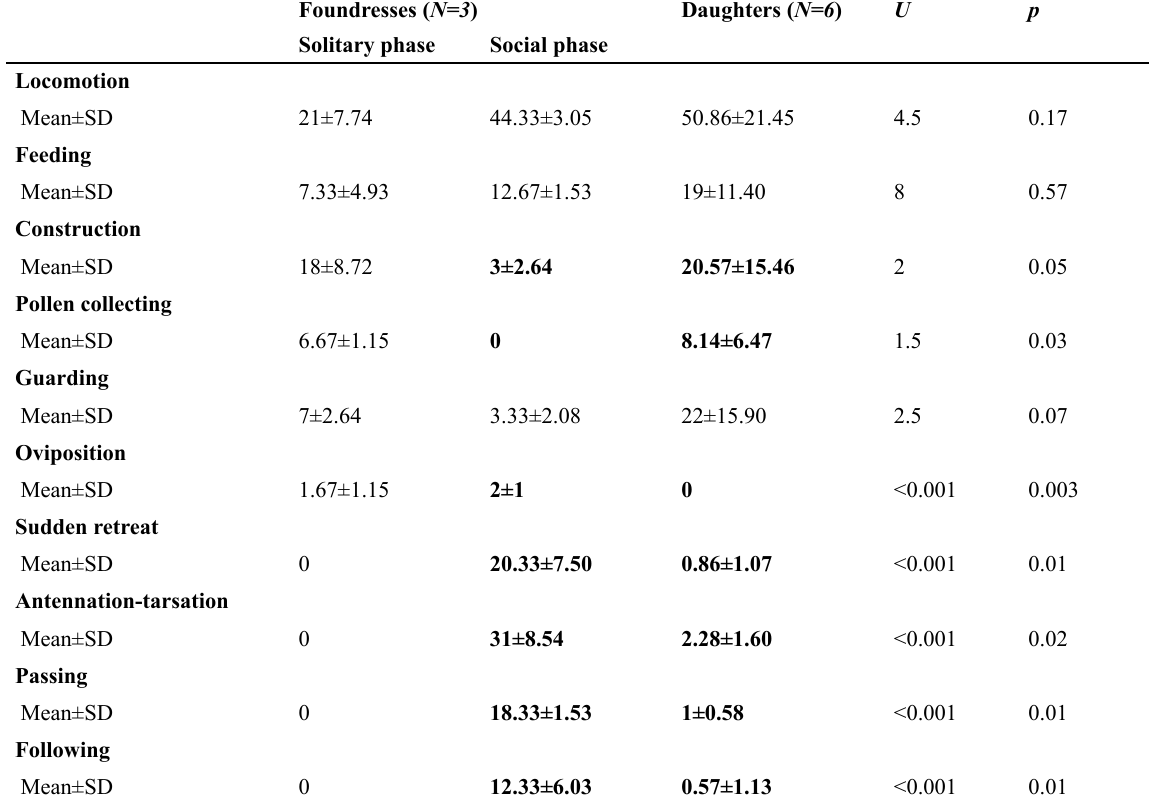
Table 1 . Activities and interactions performed by foundresses and daughters observed in three nests of Augochlora amphitrite . Median frequencies and standard deviation (SD) are presented for each type of activity and interaction. Bold values